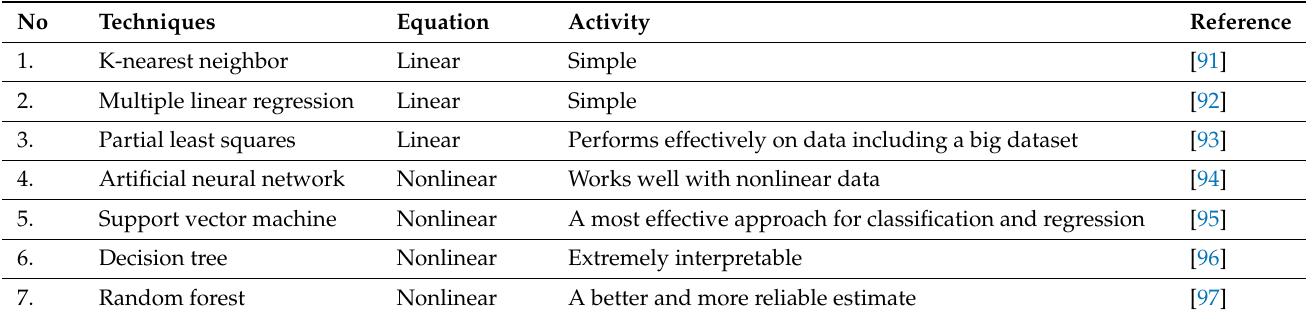
Table 3. A list of techniques and mathematical equations used in QSAR modeling as well as drug design.